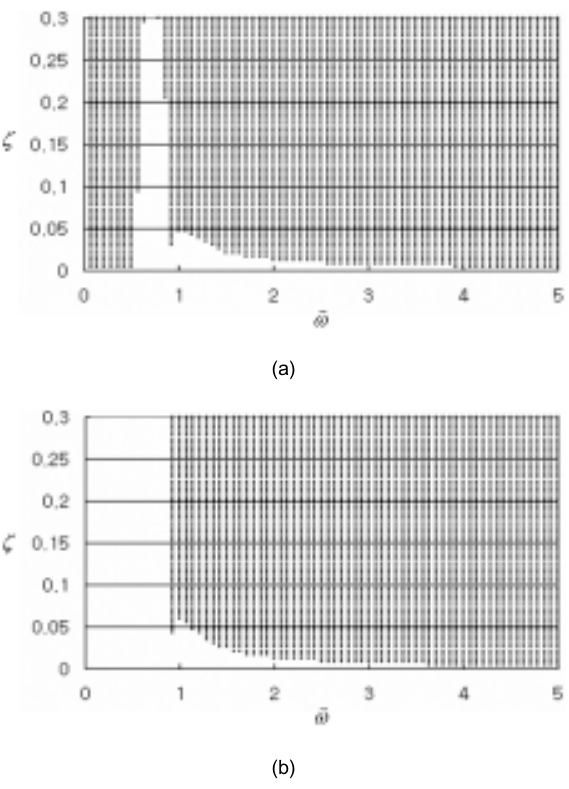
Fig. 8. Comparison of stability for the variation of ˜ ω and ς . (a) Pendulum Automatic Dynamic Balancer. (b) Ball Automatic Dynamic